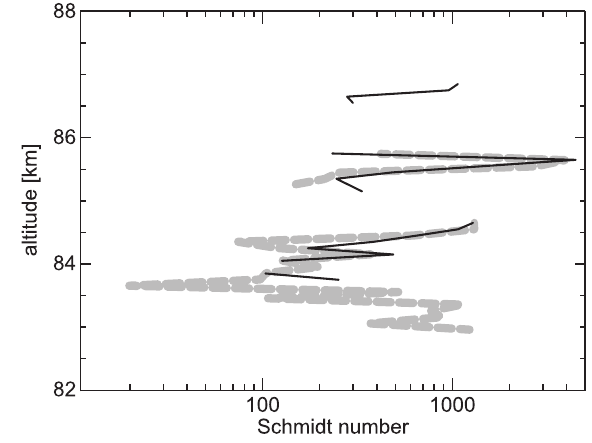
Fig. 7. Schmidt numbers derived from charged particle density and turbulence measurements during ECOMA flight. Thin black: using ε -values from ALWIN radar measurements. Bold grey: using in situ turbulence